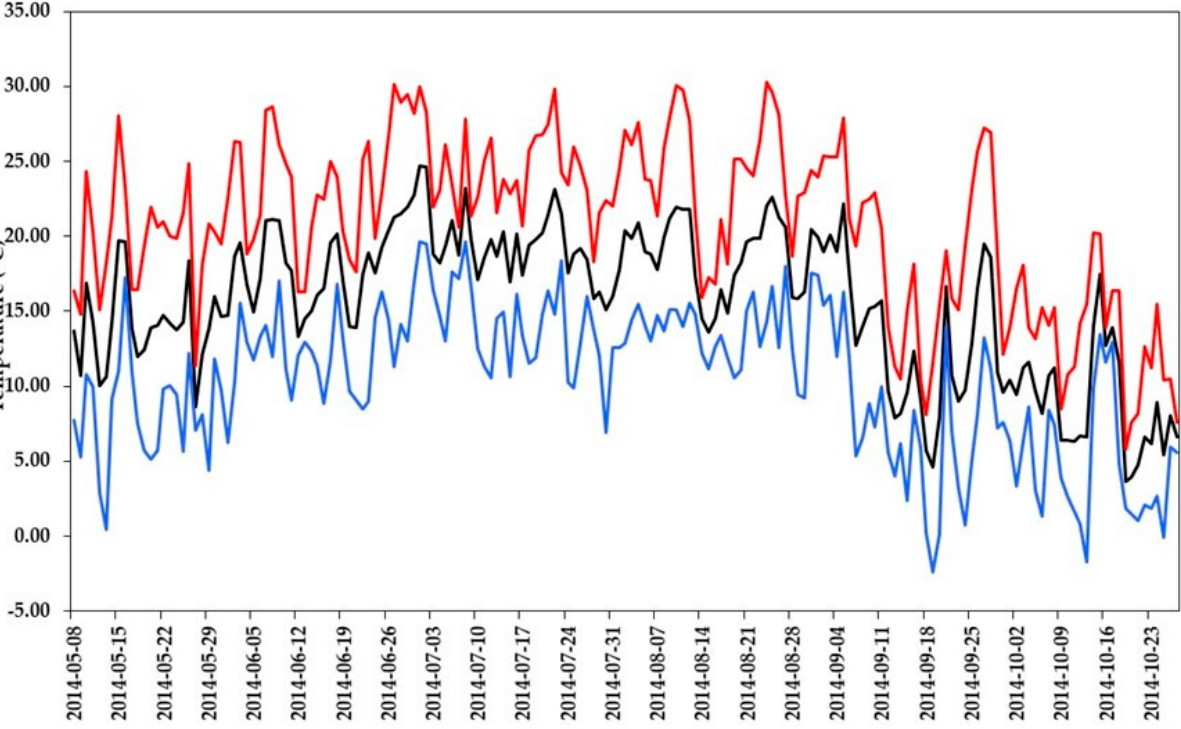
Figure 1. Variation of maximum (red), mean (black) and minimum (blue) daily air temperatures 2 m above the ground outside the tunnel at Grandes-Piles, a public forest nursery (Grandes-Piles, Québec, QC, Canada).